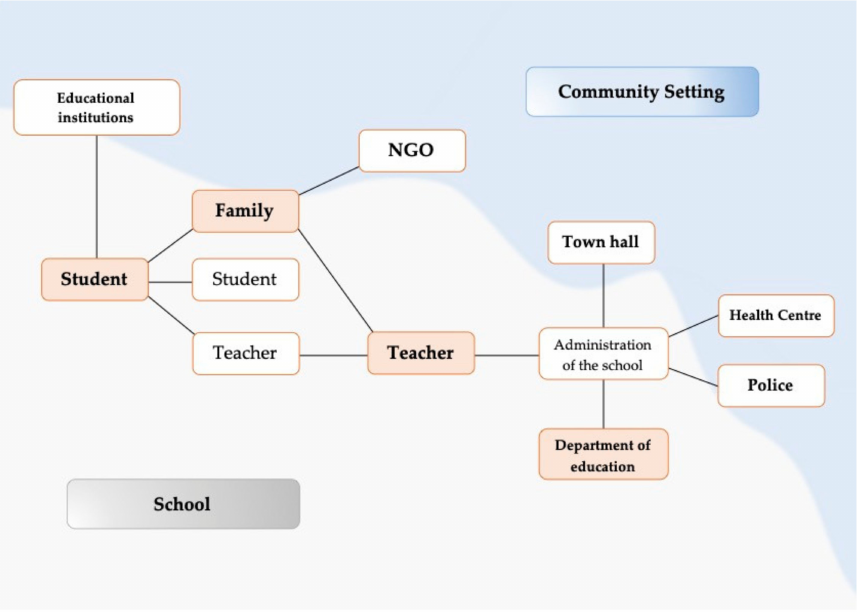
Figure 2. Educational community. Self-made